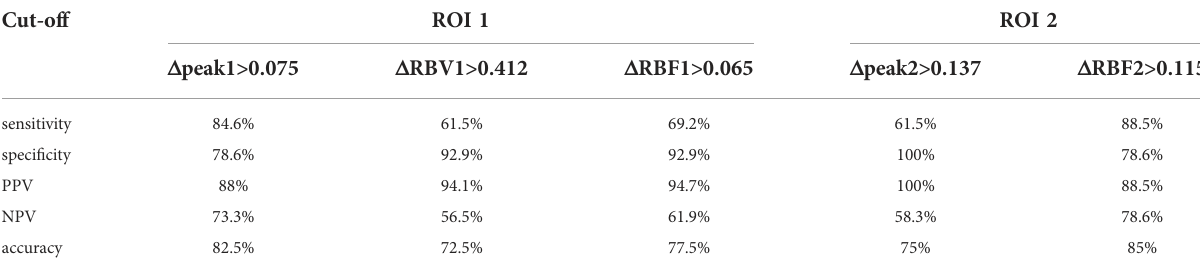
TABLE 4 Comparison of sensitivity, speci fi city, accuracy, PPV and NPV (%) of cut-off value of parameters between ROI 1 and ROI 2. Cut-off ROI 1 ROI 2